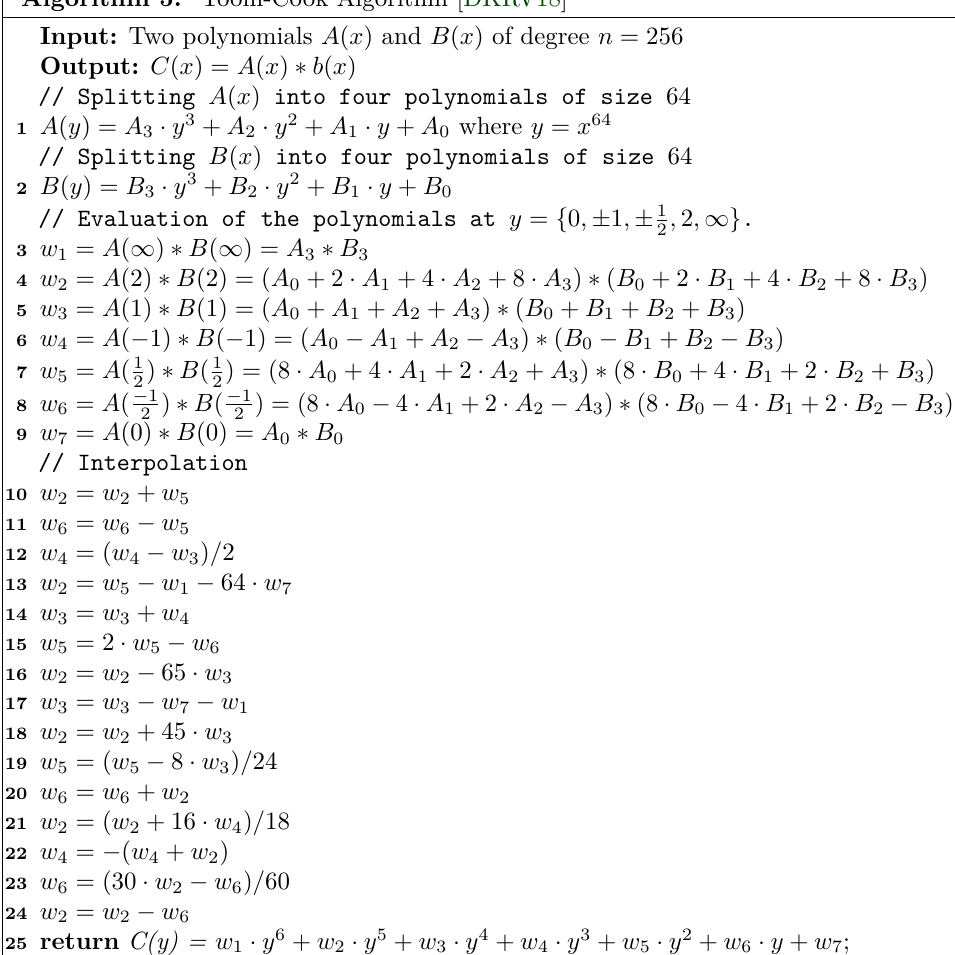
Algorithm 5: Toom-Cook Algorithm